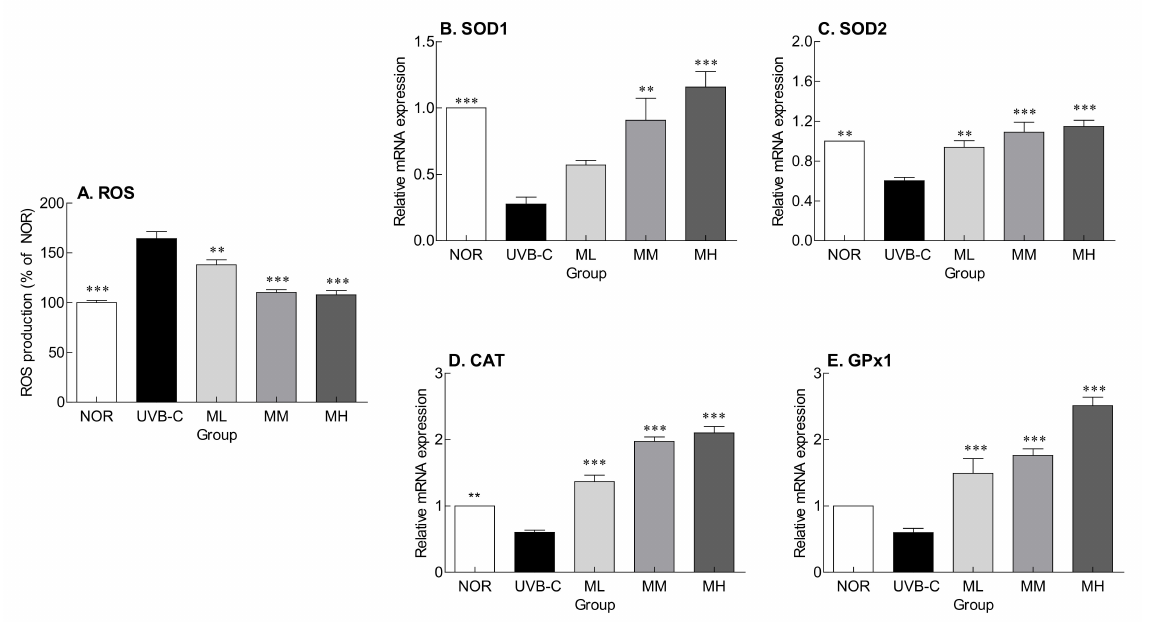
Figure 4. Effects of milk phospholipids on ROS production ( A ) and the expression of genes en- coding the antioxidant enzymes SOD1 ( B ), SOD2 ( C ), CAT ( D ), and GPx1 ( E ) in UVB-irradiated hairless mice. NOR: oral administration of saline without UVB irradiation; UVB-C: oral adminis- tration of saline under UVB irradiation; ML: oral administration of low-dose (50 mg/kg b.w.) milk phospholipids under UVB irradiation; MM: oral administration of medium-dose (100 mg/kg b.w.) milk phospholipids under UVB irradiation; MH: oral administration of high-dose (150 mg/kg b.w.) milk phospholipids under UVB irradiation. Data are expressed as means ± standard error ( n = 6). ** p < 0.01 and *** p < 0.001 vs. UVB-C group (Tukey’s test). ROS: reactive oxygen species; CAT: catalase; SOD: superoxide dismutase; Gpx-1: glutathione peroxidase-1.